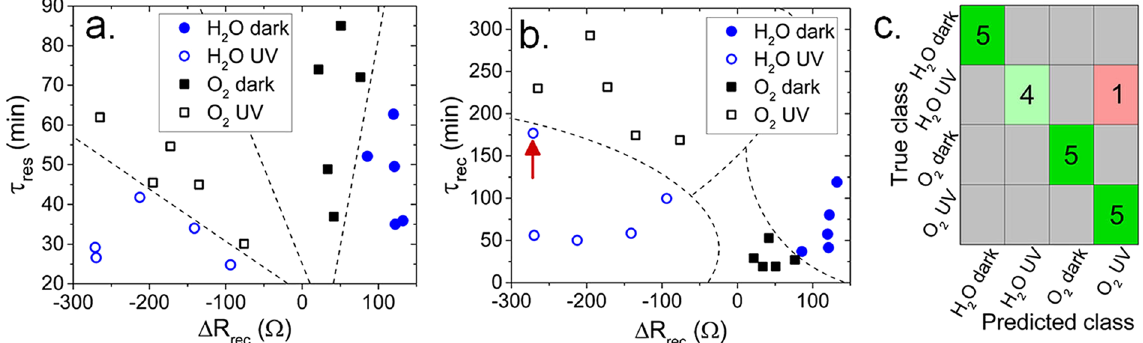
Figure 7. Example of LDC model used to distinguish between H 2 O and O 2 environments in the dark and under UV irradiation in 2-dimensional τ res - Δ R rec parameter space. ( a ) Example of environment classification using a CDC model in τ rec - Δ R rec space. ( b ) Example of a confusion matrix for classification results using linear and cubic SVM learning. ( c ) The error corresponds to the point identified by the red arrow in ( b